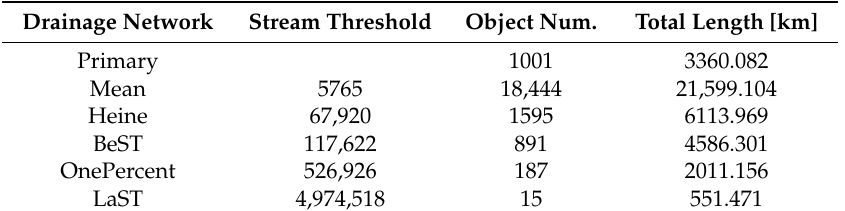
Table 2. The statistics related to the primary drainage network and the five drainage networks derived according to five distinctive stream thresholds.